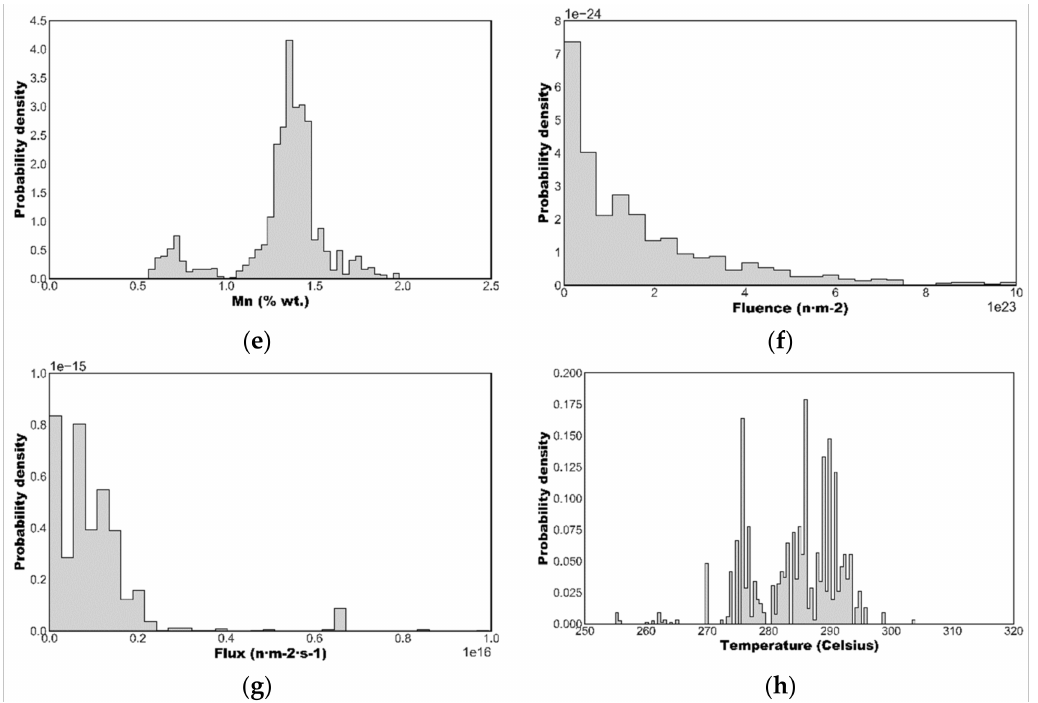
Figure 1. Histograms showing the distribution of the numeric features in the PLOTTER database.